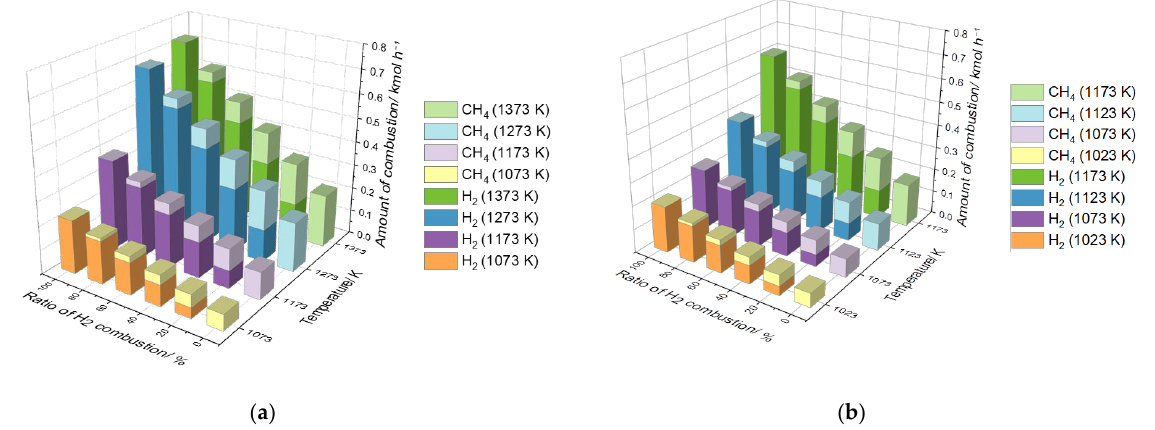
Figure 5. Amount of fuel (CH 4 and H 2 ) consumption for methane pyrolysis (MP) systems of ( a ) thermal methane pyrolysis (TMP-S1) and ( b ) catalytic methane pyrolysis (CMP-S2) in temperature of 1073 – 1373 K and 1023 – 1173 K.